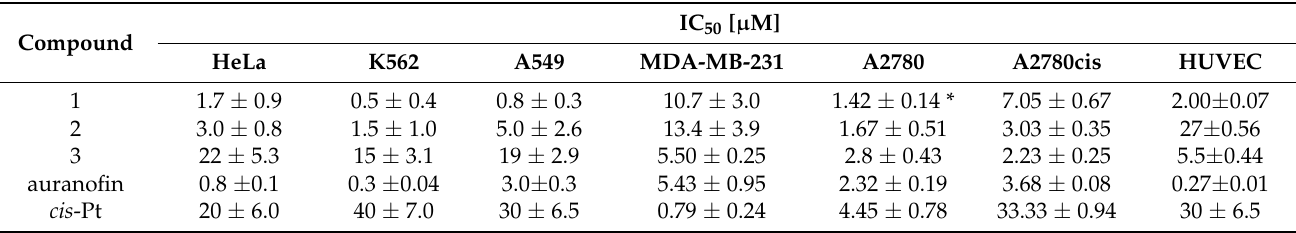
Table 2. Cytotoxic activity of studied compounds against HeLa (human cervix carcinoma), K562, A549, MDA-MB-231, A2780, A2780cis, and HUVEC (human umbilical vein endothelial) cells after 48 h exposure. IC 50 values are means ± SD of three independent experiments.